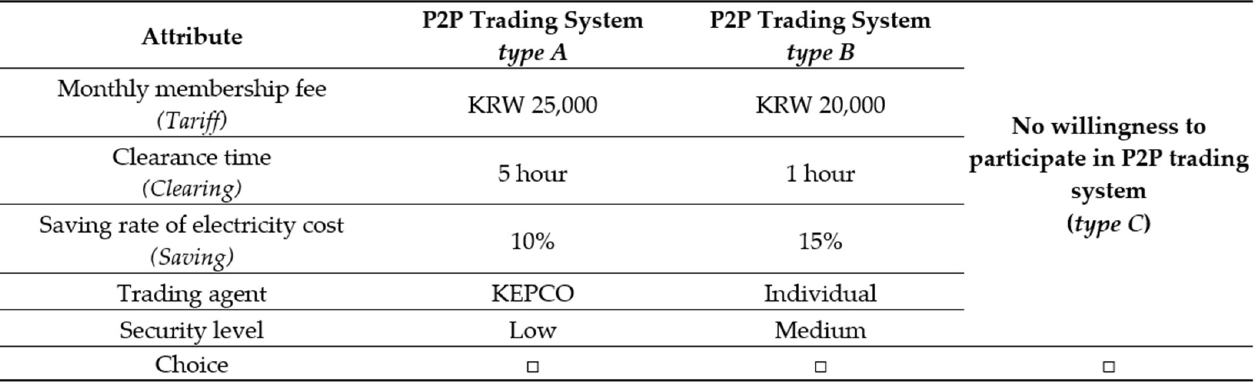
Figure 2. A Sample Choice Questionnaire.